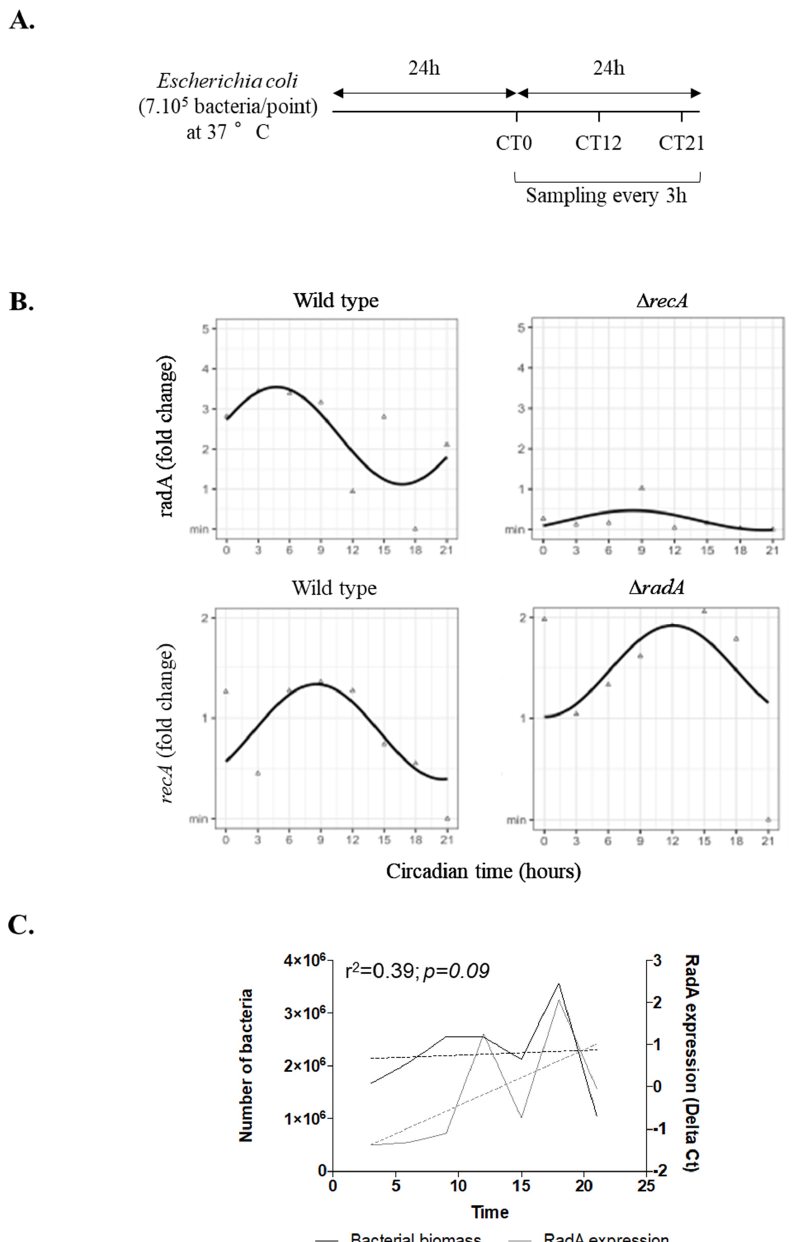
Figure 2. Circadian rhythm of gene expression in Escherichia coli . Bacteria (wild-type E. coli , radA and recA mutants) were spotted on blood agar on 4 points/agar with 7. 10 5 bacteria per point and incubated at 37 ◦ C for 24 h. Colonies were then collected every 3 h for 24 h at a constant temperature (37 ◦ C) without light/dark cycle. ( A ) Schematic representation of the experimental set-up. CT represents the circadian time; the grey bar is daylight, and the black bar is night. ( B ) The expression of the radA and recA genes was evaluated by q-RTPCR and expressed as fold change using the 2 − ∆∆ Ct formula. The triangles correspond to the raw data without Cosinor transformation; the sinusoids represent the expression of the genes over time after adjustment of the values by the Cosinor model. Statistical analysis was performed using the cosine function in R studio (the results are representatives of three experiments). ( C ) The number of bacteria (bacterial biomass, black) and radA gene expression (calculated with ∆ Ct formula, grey) were evaluated by qPCR and q-RTPCR, respectively. Pearson (cid:48) s correlation test was used to analyze the correlation between bacterial biomass and radA gene expression; the dashed line represents the linear regression. Statistical significance was defined for a p value <